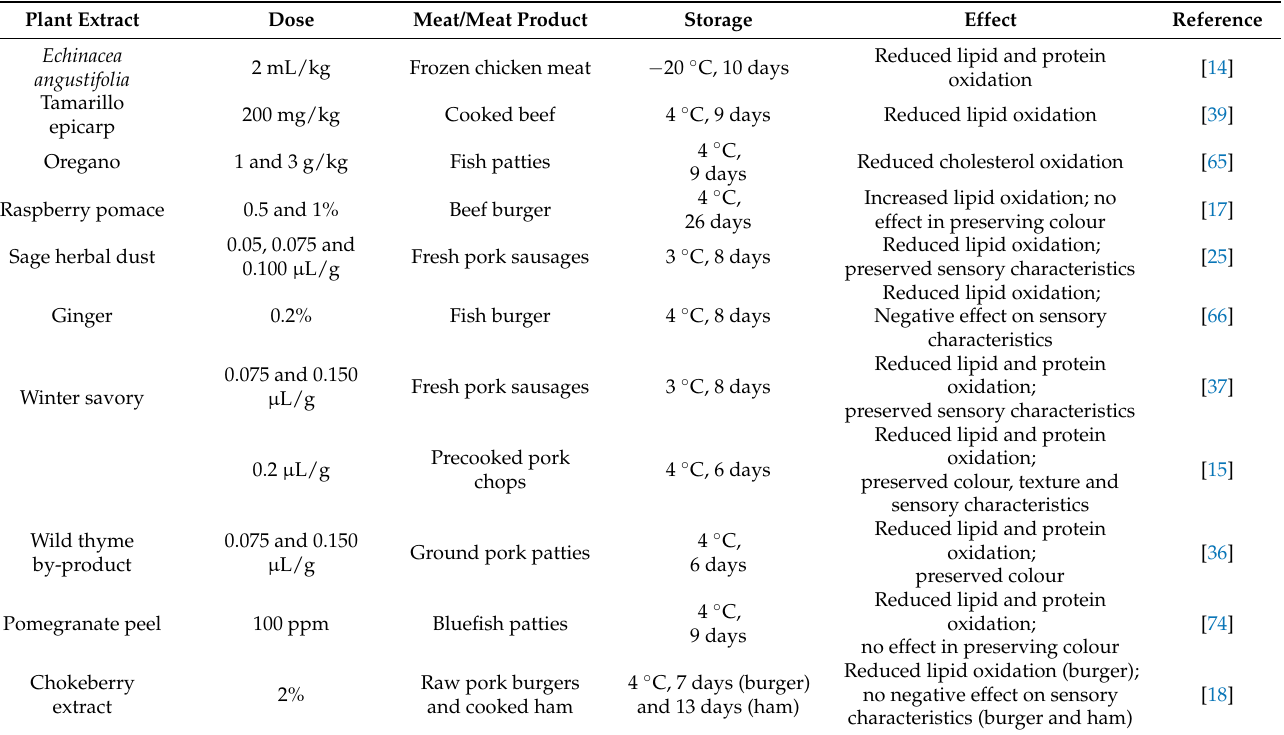
Table 2. Antioxidant effects of extracts obtained by SFE in meat and meat products.